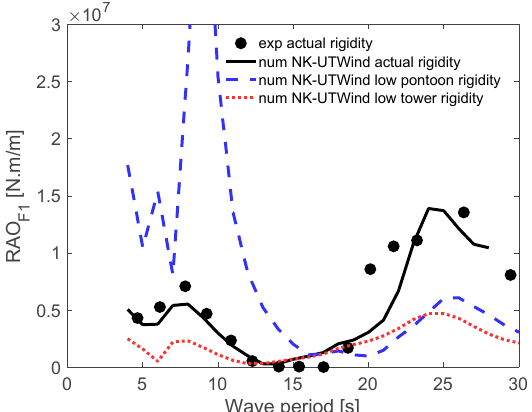
Figure 20. Influence of the tower and pontoon rigidities on the RAO bending moment at the tower-base gage (F1), and its comparison between the experiment and calculation.